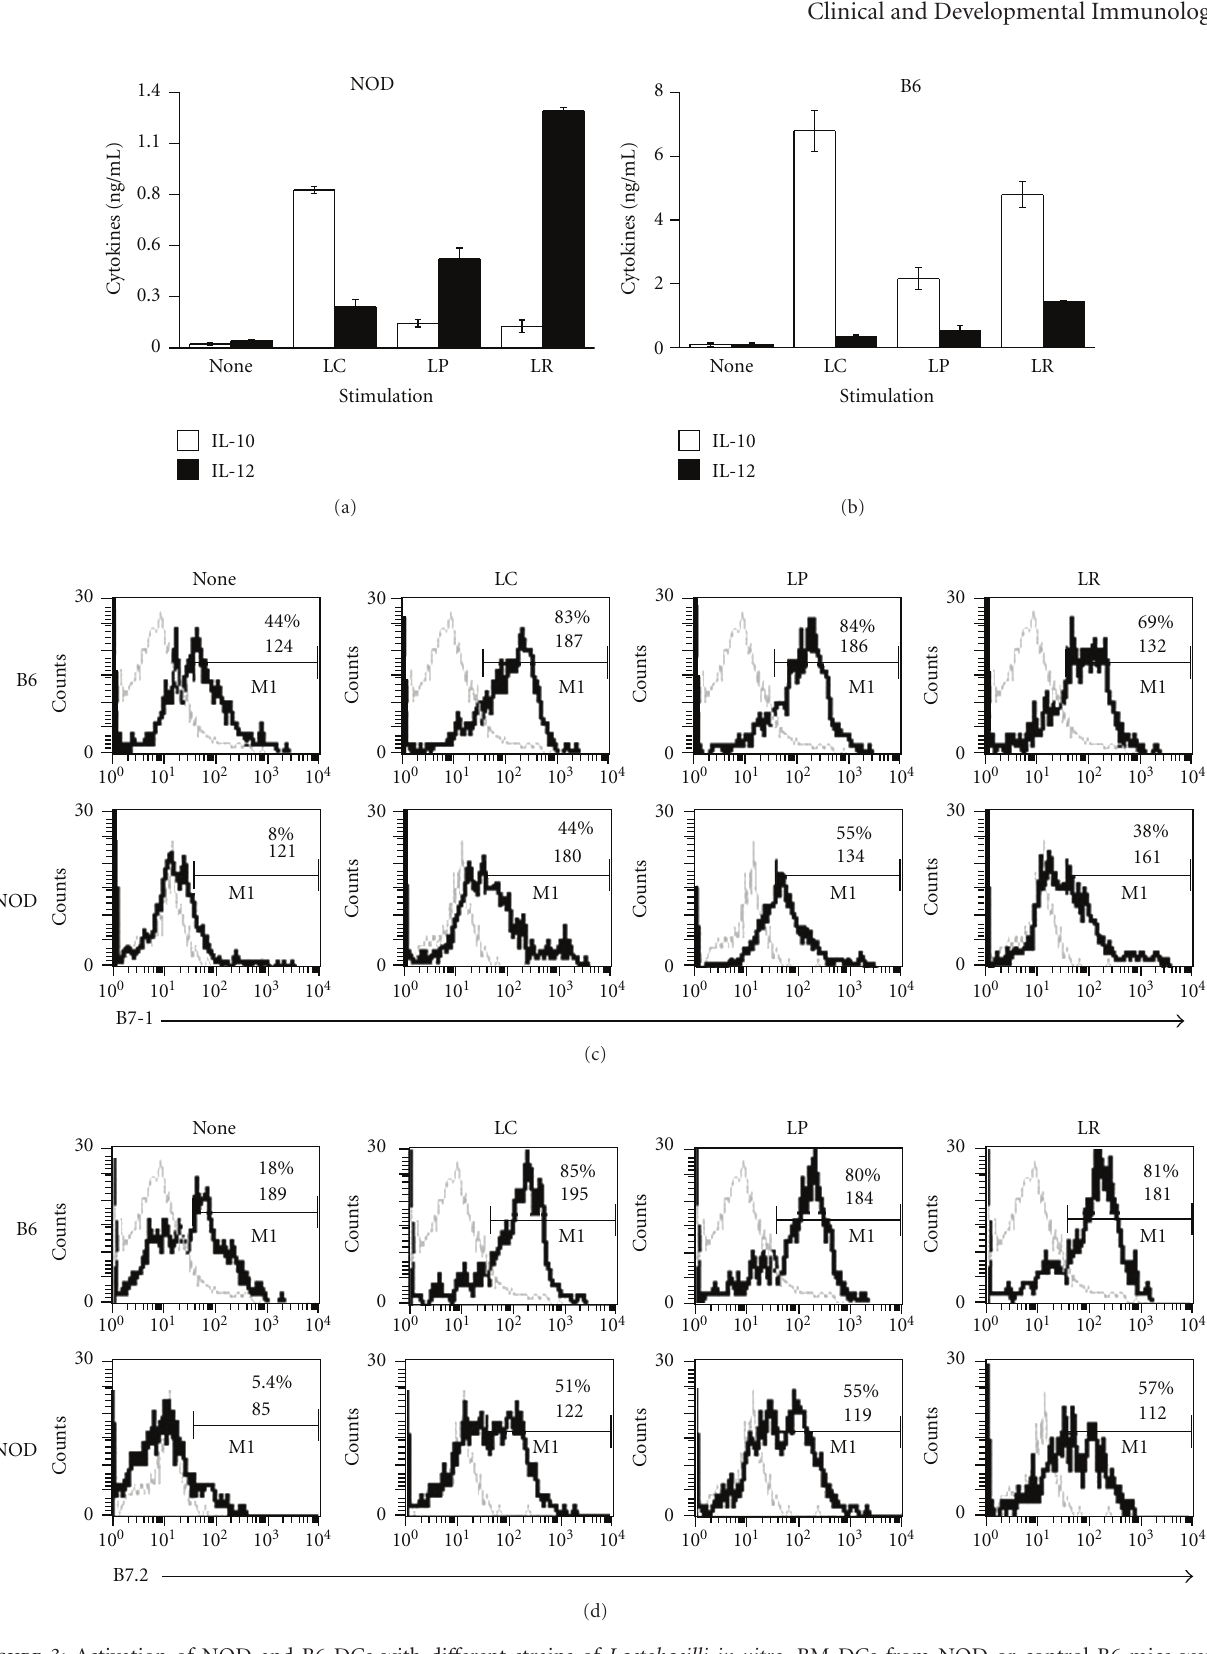
Figure 3: Activation of NOD and B6 DCs with di ff erent strains of Lactobacilli in vitro . BM-DCs from NOD or control B6 mice were stimulated for 24hrs with 10 × 10 6 CFU/mL L. casei (LC), L. plantarum (LP), L. reuteri (LR), or medium alone (none). After 24hrs, supernatants were collected and measured by ELISA for the presence of IL-10 or IL-12 (a and b), or cells were collected and labeled with anti-CD11c, anti-CD11b, and anti-B7-1 (c) or anti-B7-2 (d) antibodies, and analyzed by FACS after gating on CD11b + CD11c int